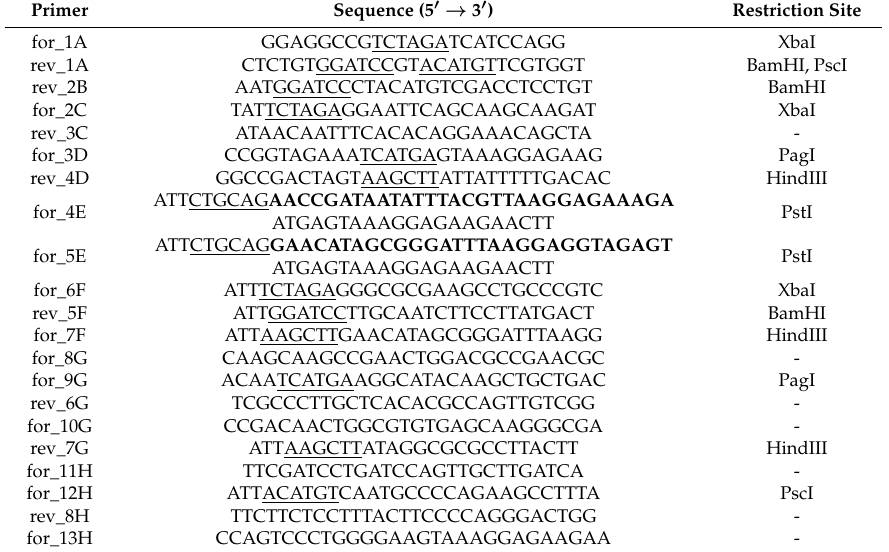
Table 2. Primers used for vector cloning. Sequences in bold are synthetic RBS regions calculated with the RBS Calculator [27,28]. Underlined sequences refer to restriction